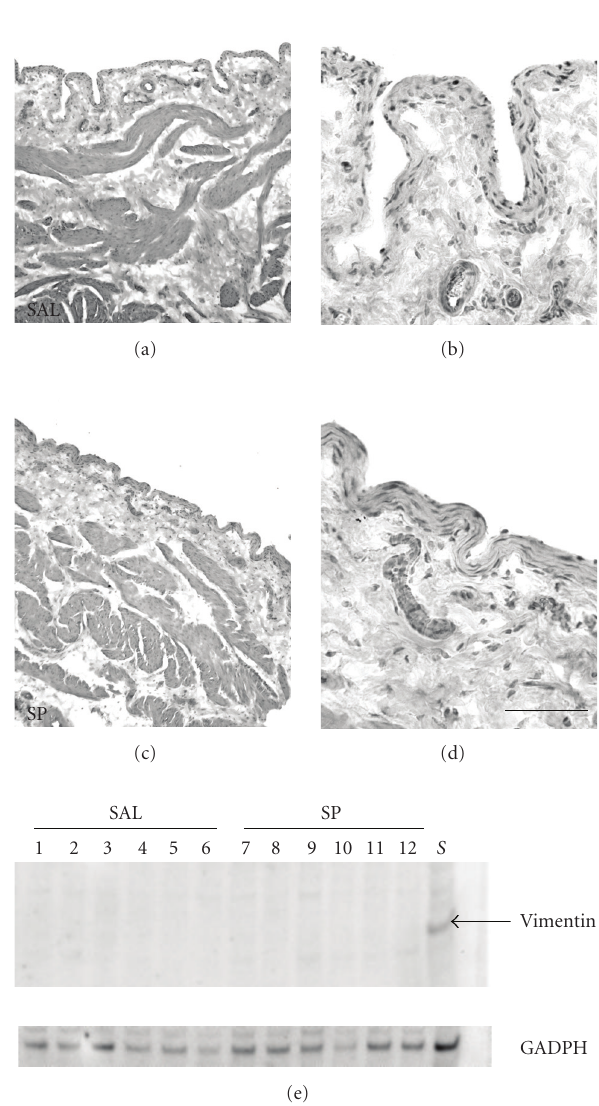
Figure 2: Epithelial aggregate separation and isolation (EASI) of rat bladder urothelium. Hematoxylin staining of scraped bladders. (a) and (b) saline-treated bladders, (c) and (d) SP-treated